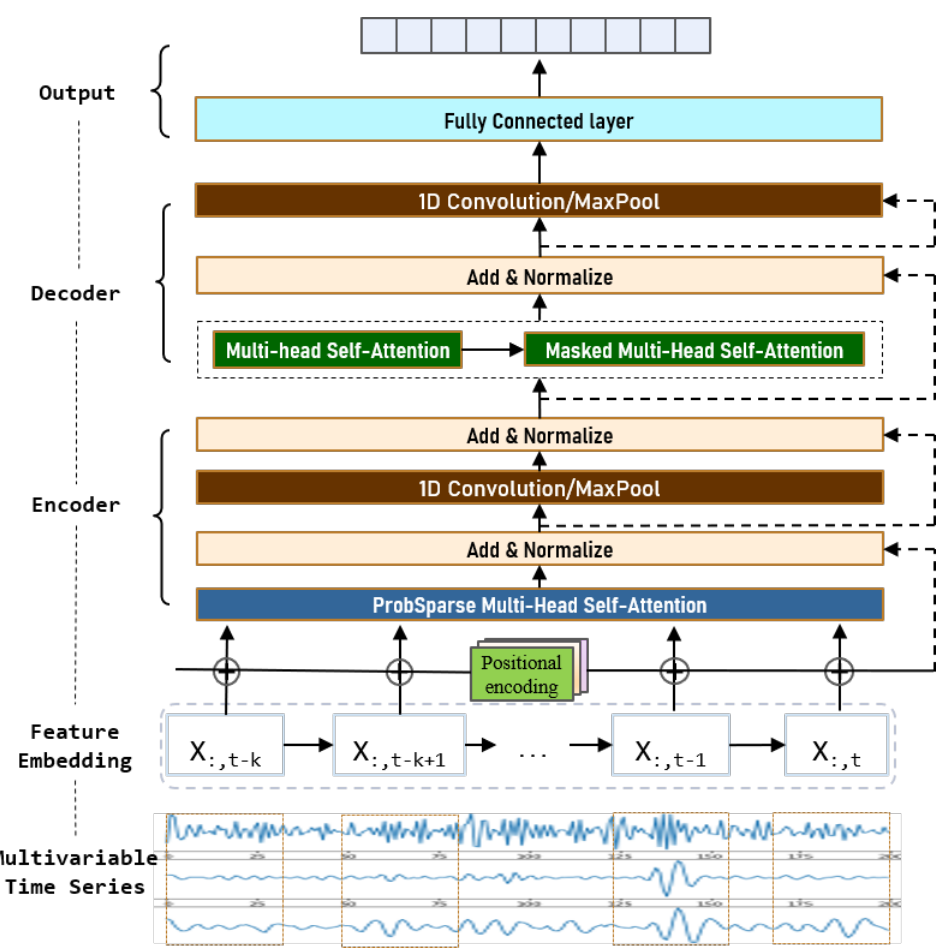
Figure 3. The architecture of SP-M-Attention.